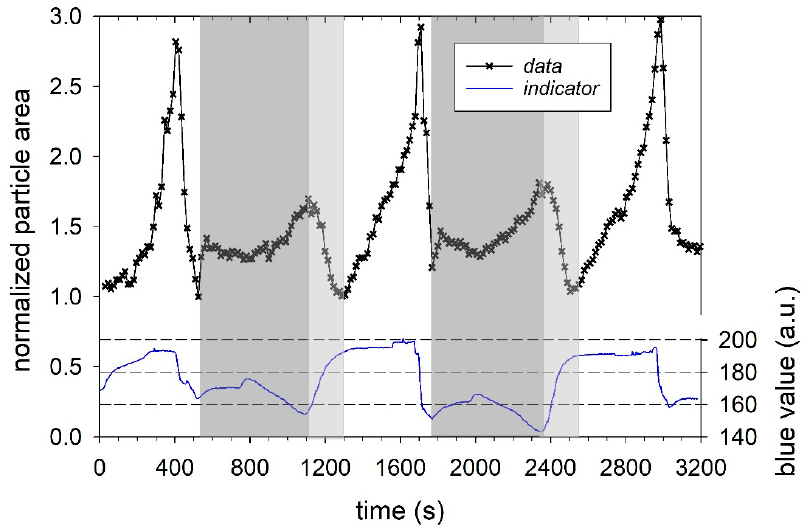
Figure 2. Swelling/de-swelling cycles of a single casein microparticle induced by pH-jumps. The blue value of the indicator shown below indicates the repeated pH progression between pH 11 and pH 1 and back again. Gray areas indicate the time between cycles, which were not considered for further